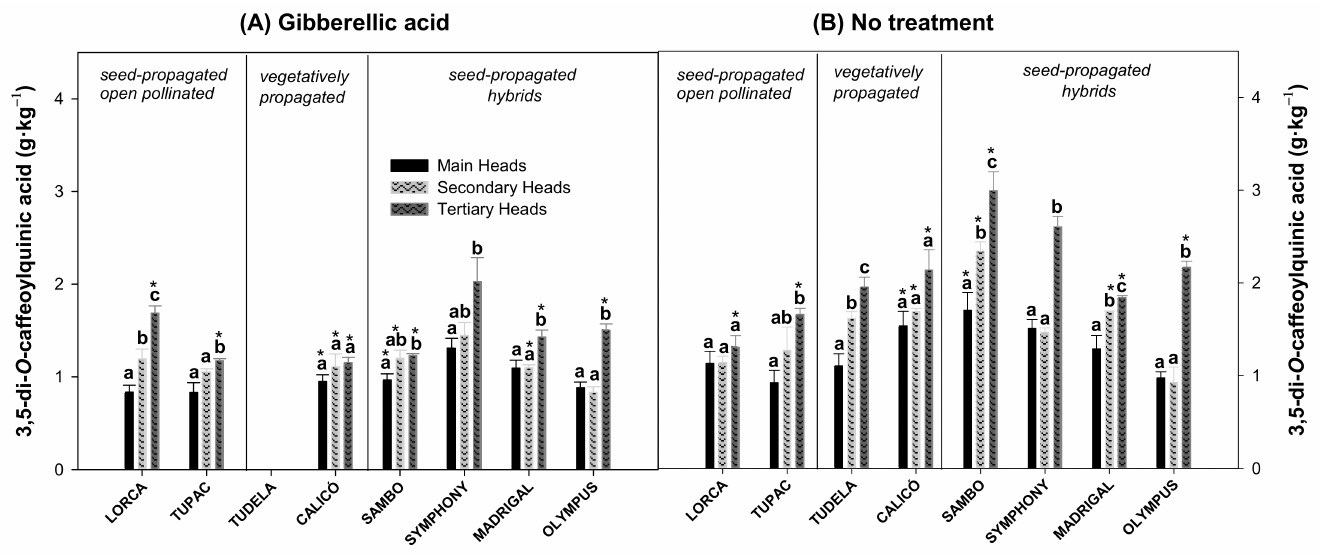
Figure 3. The 3,5-di- O -caffeoylquinnic acid content (g · kg − 1 ) of globe artichoke cultivars influenced by flower head order (main, secondary, and tertiary heads) and treatment (gibberellic acid ( A ) or no treatment ( B )). Data are the mean ± SE. Different letters show significant differences ( p < 0.05 according to HSD Duncan’s test) among flower head orders for each artichoke cultivar and treatment. Significant differences between both treatments ( p < 0.05 according to Student’s t -test) were expressed as * placed in each flower head order for each artichoke